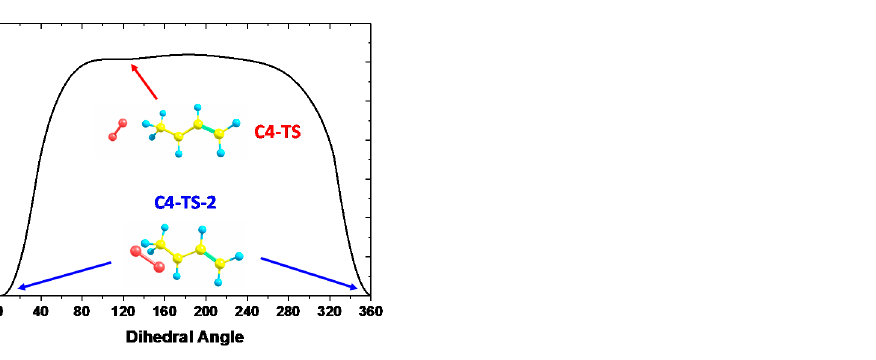
Figure 4. Internal rotor potential of the CC − OO dihedral angle for the two TSs on C 4 H 7 1-3 Ȯ 2 PES. Table 3. Comparison of barrier heights. (Unit: